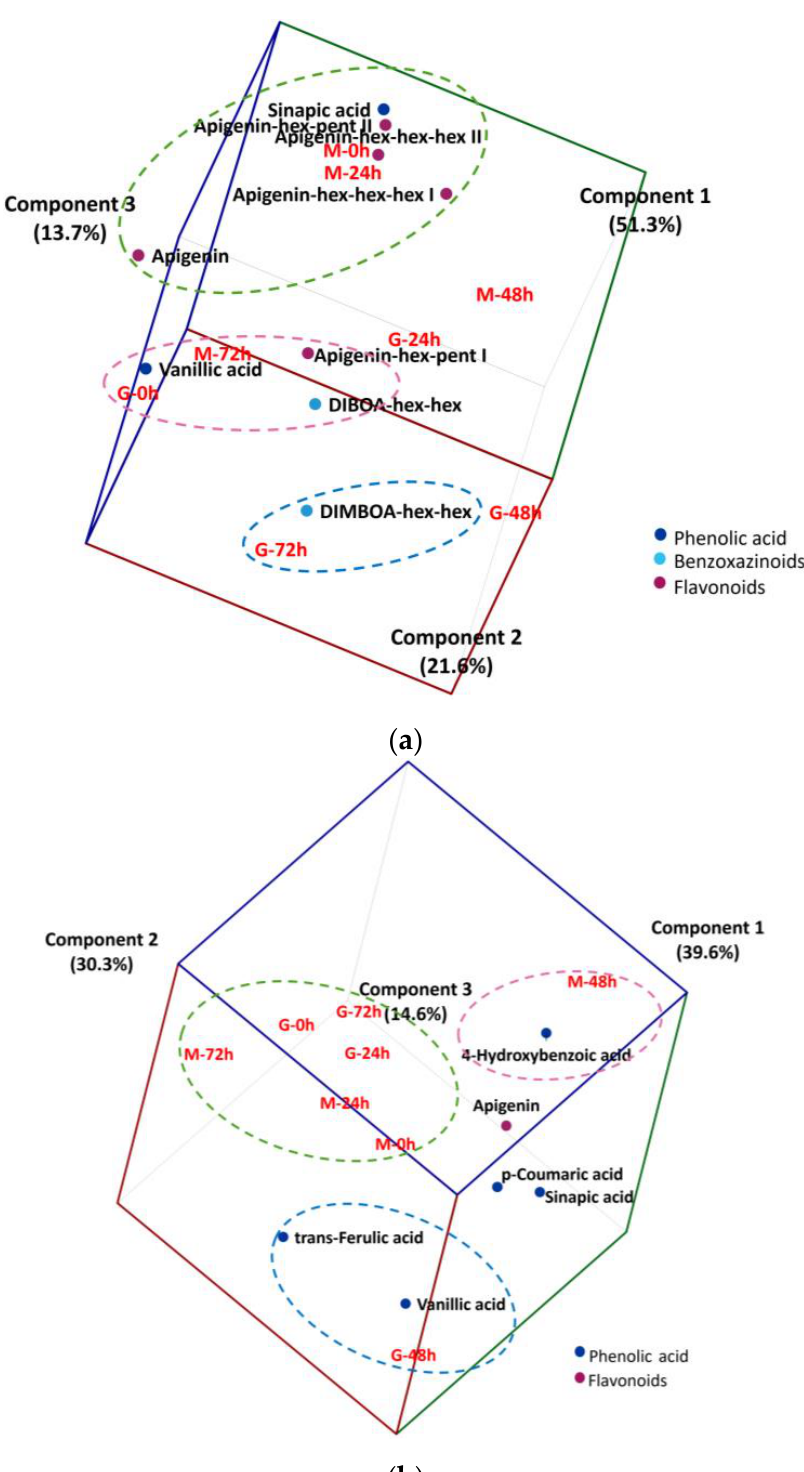
Figure 2. Three-dimensional biplot of wheat cultivars (G = Guaraim, M = Marcante) at different germination times (0, 24, 48 and 72 h) (scores) versus phytochemicals (loadings) in relation to the main components of principal component analysis for the free phytochemical fraction ( a ) and for the bound phytochemical fraction that was released after alkaline hydrolysis ( b ); a = 86.6% and b = 84.5%. Colored dashed ellipses indicate the proximity among samples and variables.